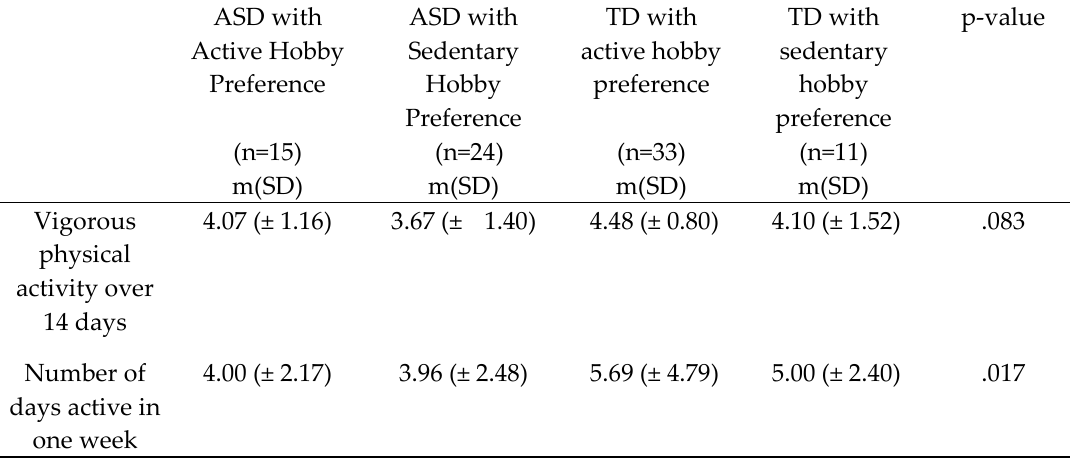
Table 2. Physical Activity levels among groups by hobby